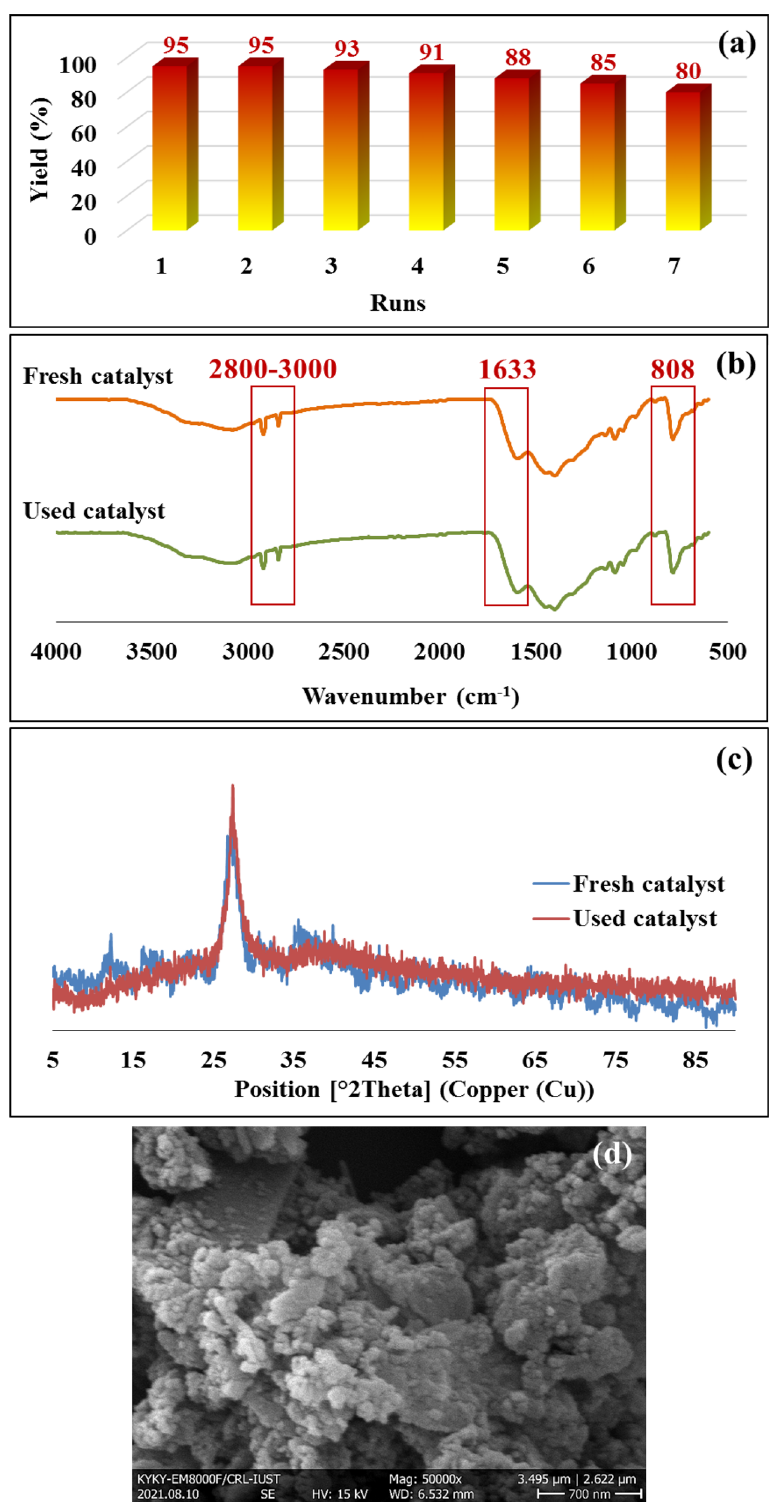
Figure 8. ( a ) Recyclability of the CN–Pr–Met–Cu(II) in tandem oxidative amidation of benzyl alcohol with benzylamine hydrochloride salt. ( b ) FT-IR, ( c ) XRD analysis of fresh and used CN–Pr–Met–Cu(II). ( d ) FE-SEM image of used